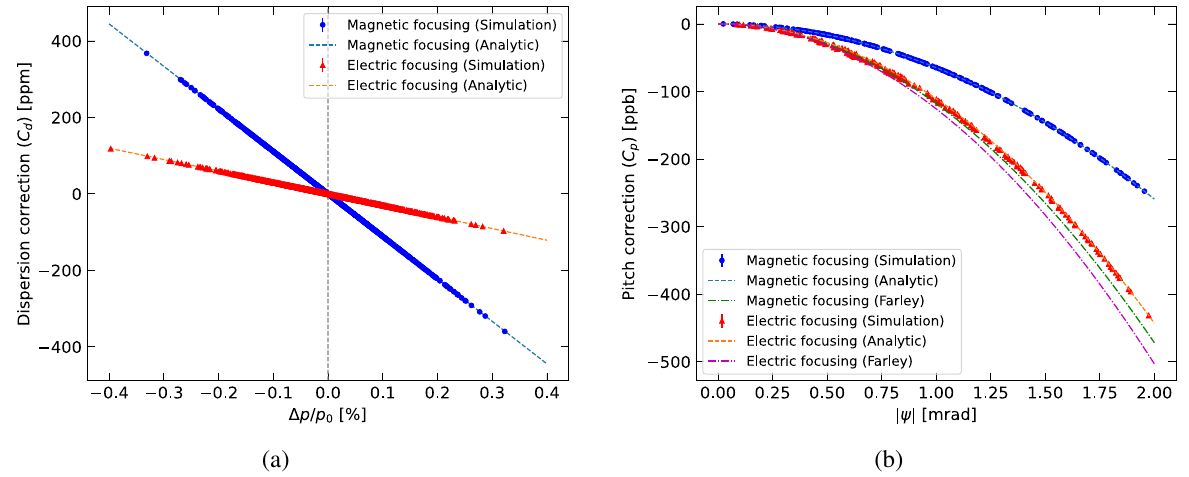
FIG. 5. The dispersion correction ( C ) and pitch correction ( C ) for the proton with a momentum 1 GeV = c, obtained by the high d p precision spin tracking simulation and the analytic estimation in the magnetic and electric focusing storage rings. Each point was obtained by fitting the simulated spin precession curve for each particle, and agreed well with the analytical estimations, indicated by the dashed lines labeled “ Analytic. ” Another theoretical prediction for the pitch correction labeled “ Farley ” from Ref. [39] was plotted as reference. (a) The dispersion correction. (b) The pitch